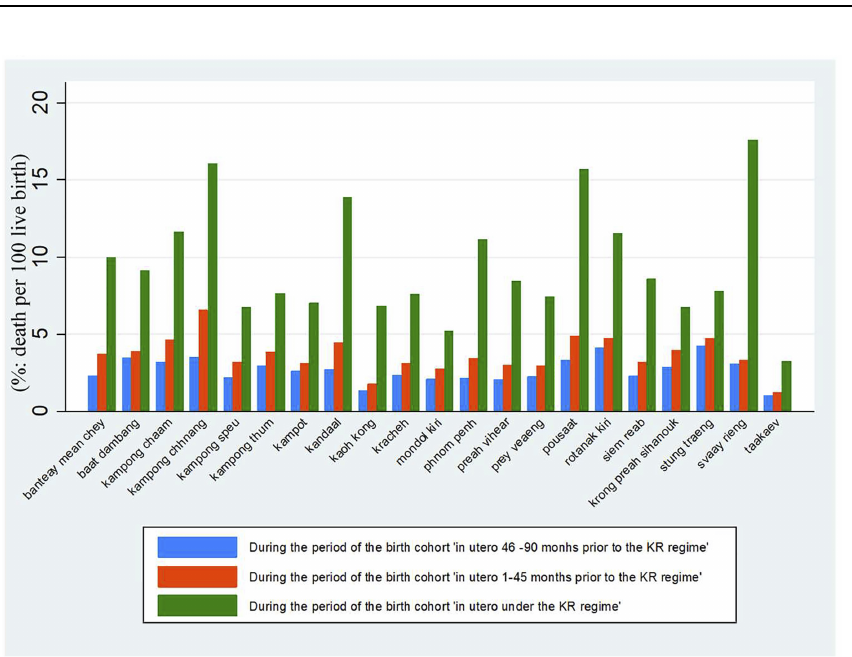
Table 2. Differential effects of